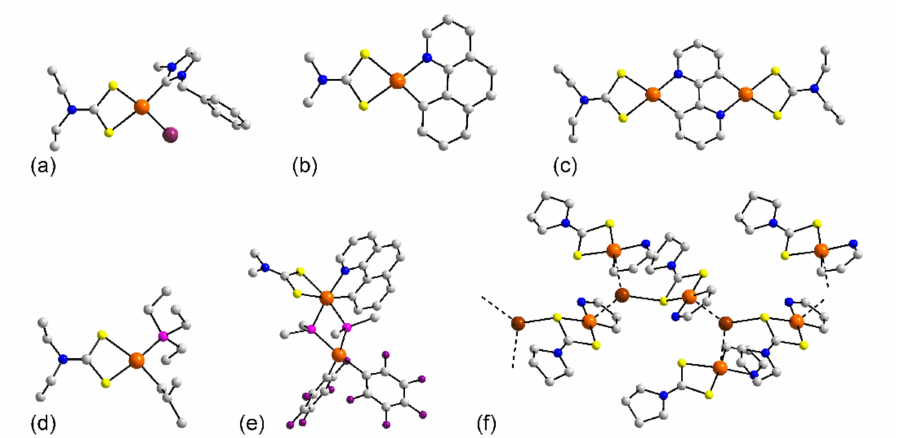
Figure 14. Molecular structures of platinum dithiocarbamate complexes: ( a ) Pt(bmi)( L 24 )I ( 244 ), ( b ) (Pt(bzq)( L 8 ) ( 245 ), ( c ) [Pt( L 24 )] 2 (bpy) in the crystal of 248 , ( d ) (PEt 3 )Pt( L 24 )(CH 2 (iPr)) ( 249 ), ( e ) Pt(bzq)( L 8 )(PPh 2 ) 2 Pt(C 6 F 5 ) 2 ( 251 ), and ( f ) the coordination polymer {Ag[Pt(bzq)( L 57 )] 2 } n in 252 .